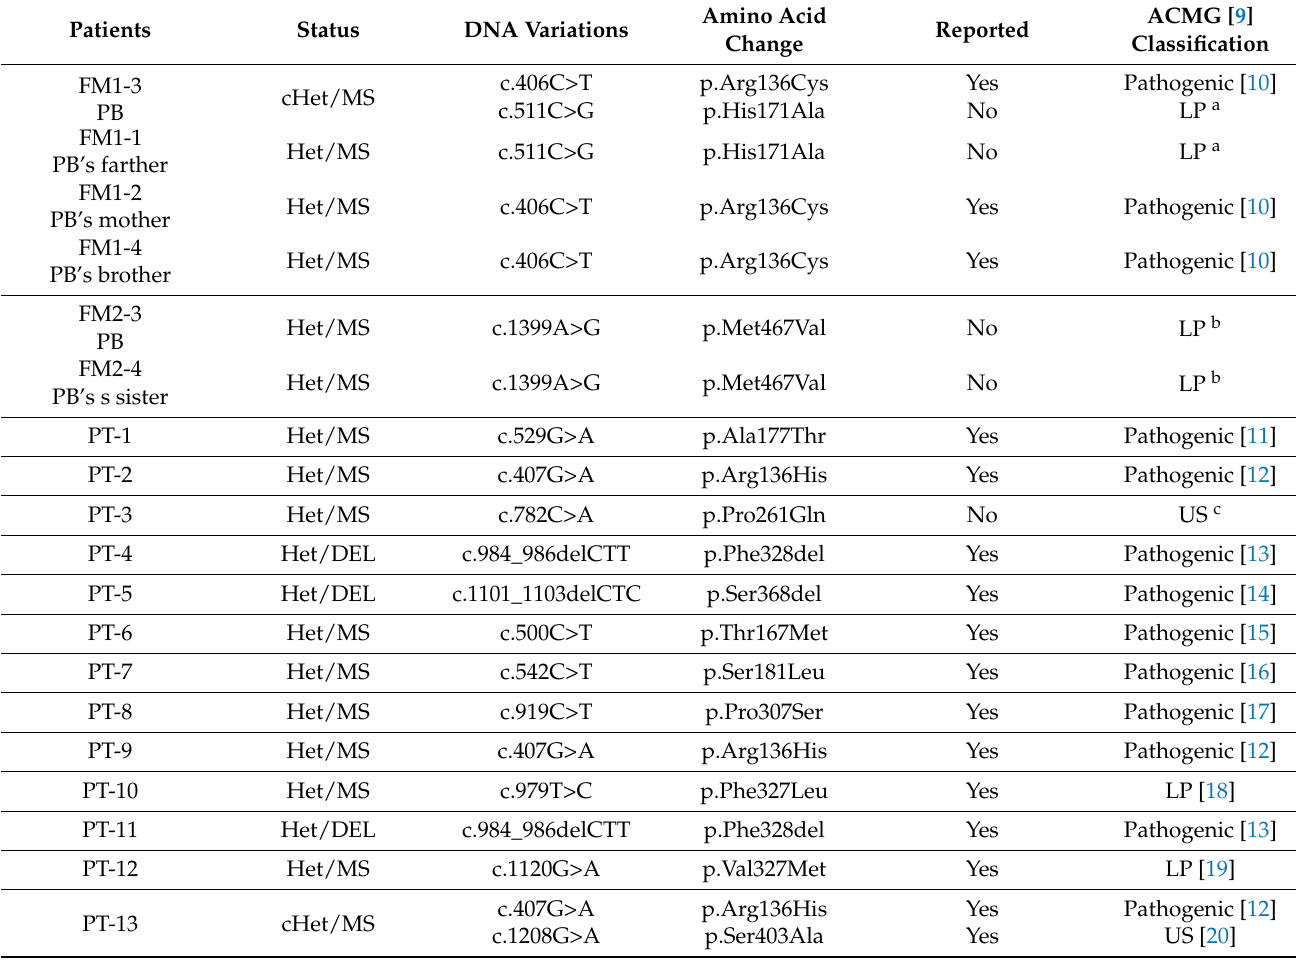
Table 5. Genetic analysis of the ALPL gene in 19